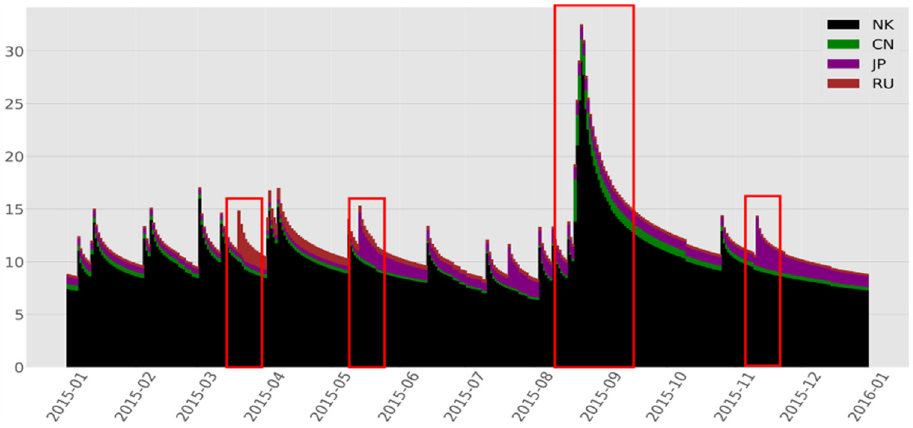
Figure 2. Provocation case-based results ( MSI_case ).